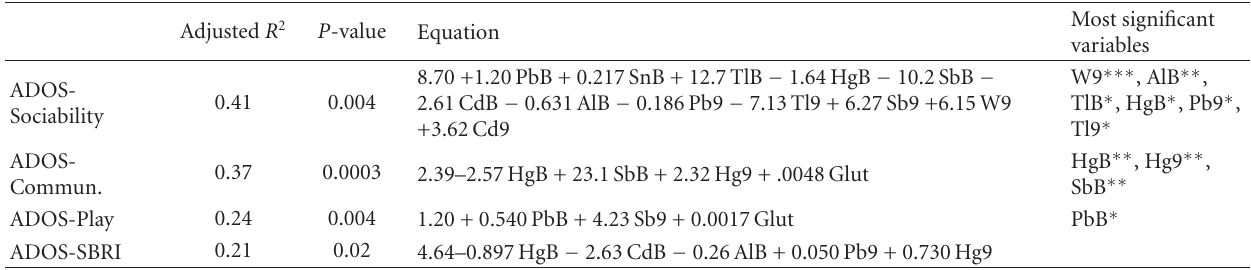
Table 6: Regression analyses of initial ados subscales versus urinary metal excretion and initial glutathione. In the regression equation, the su ffi xes for the metals refer to the value at Baseline (B) and after the 9th (9) dose of DMSA in Phase